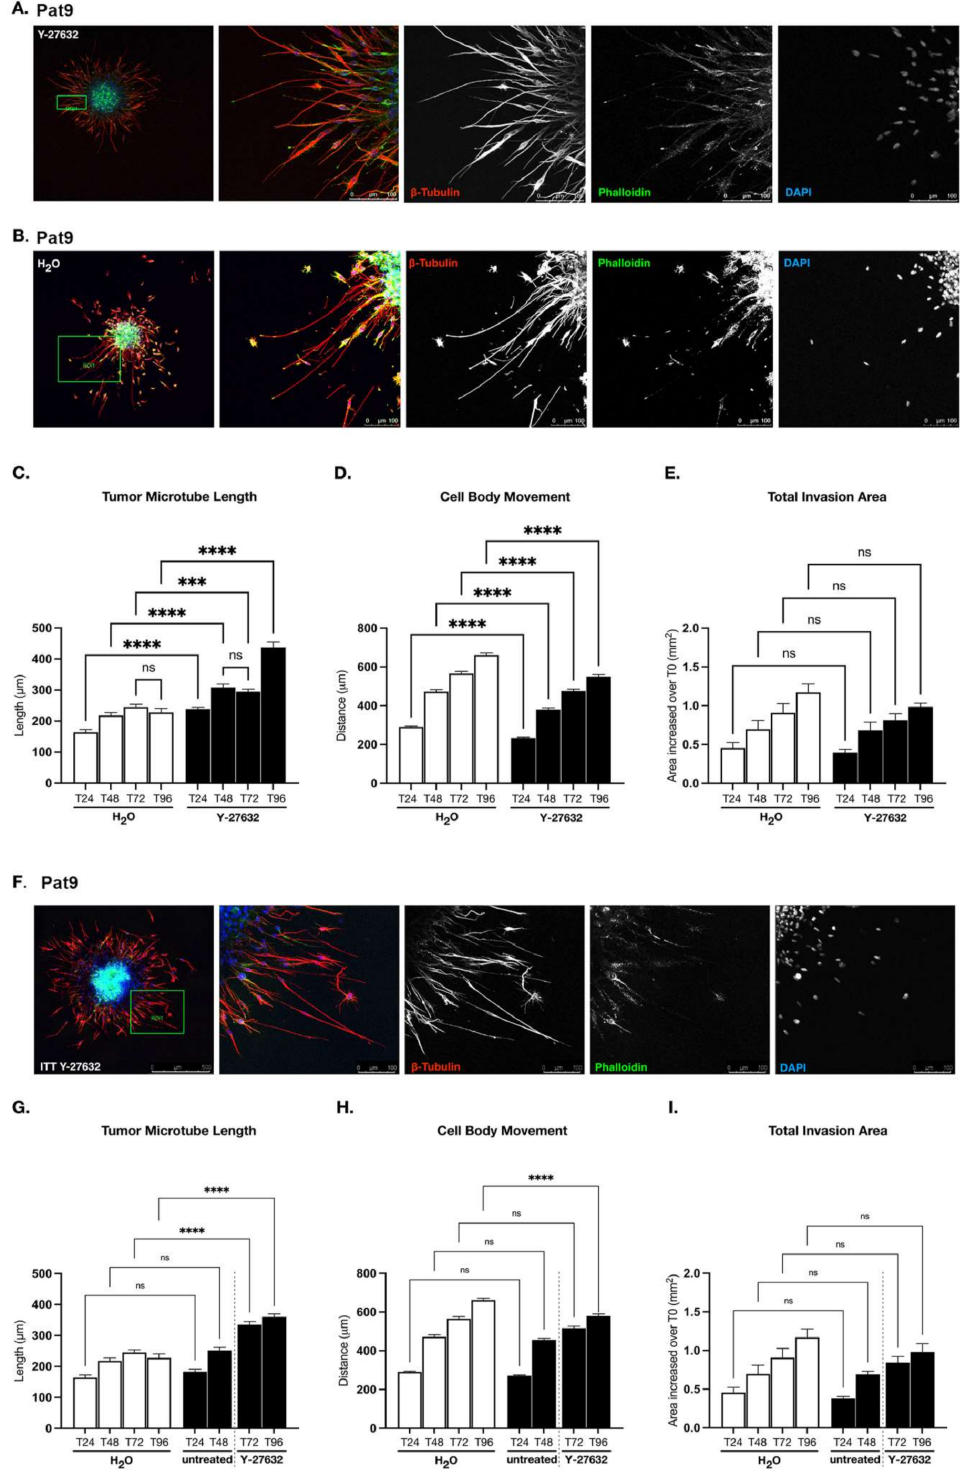
Figure 2. ROCK-directed contractility machinery regulates patient-derived GBM pro-invasive tumor microtube networks. ( A ) Confocal images of leading edge at T96 in fixed Y-27632-treated (90 µ M)